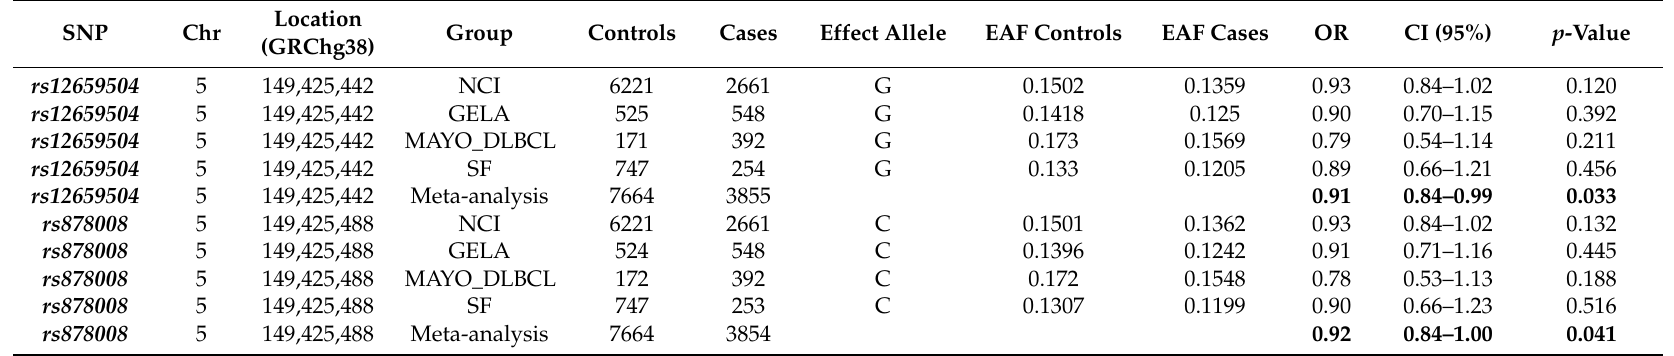
Table 8. Summary statistics for three European NHL-GWAS with an imputation scan (InterLymph Consortium) and meta-analysis (Cerhan et al. 2014) for two SNPs in high LD with rs17723799 on chromosome 5. EAF, effect allele frequency; OR, odds ratio, CI, confidence